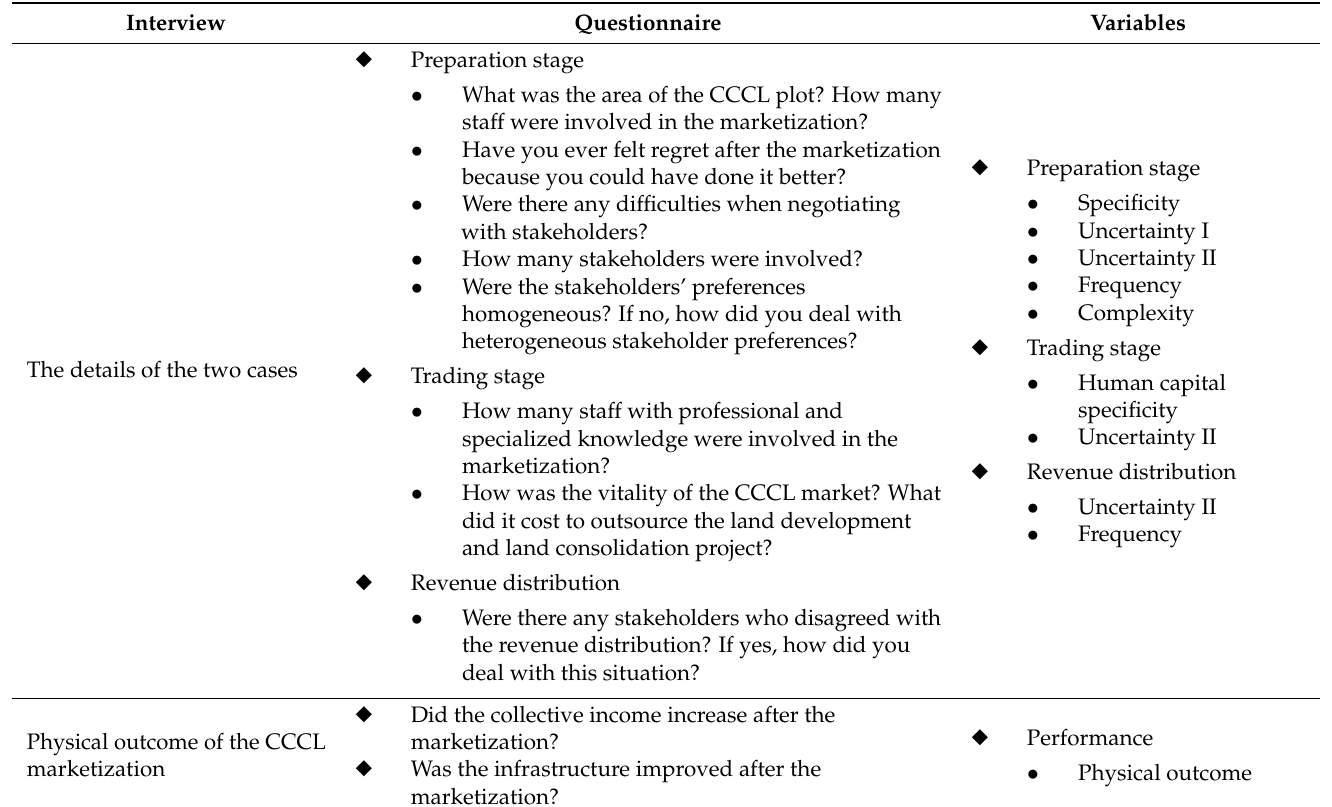
Table 3. The interview, questionnaire, and variables for village